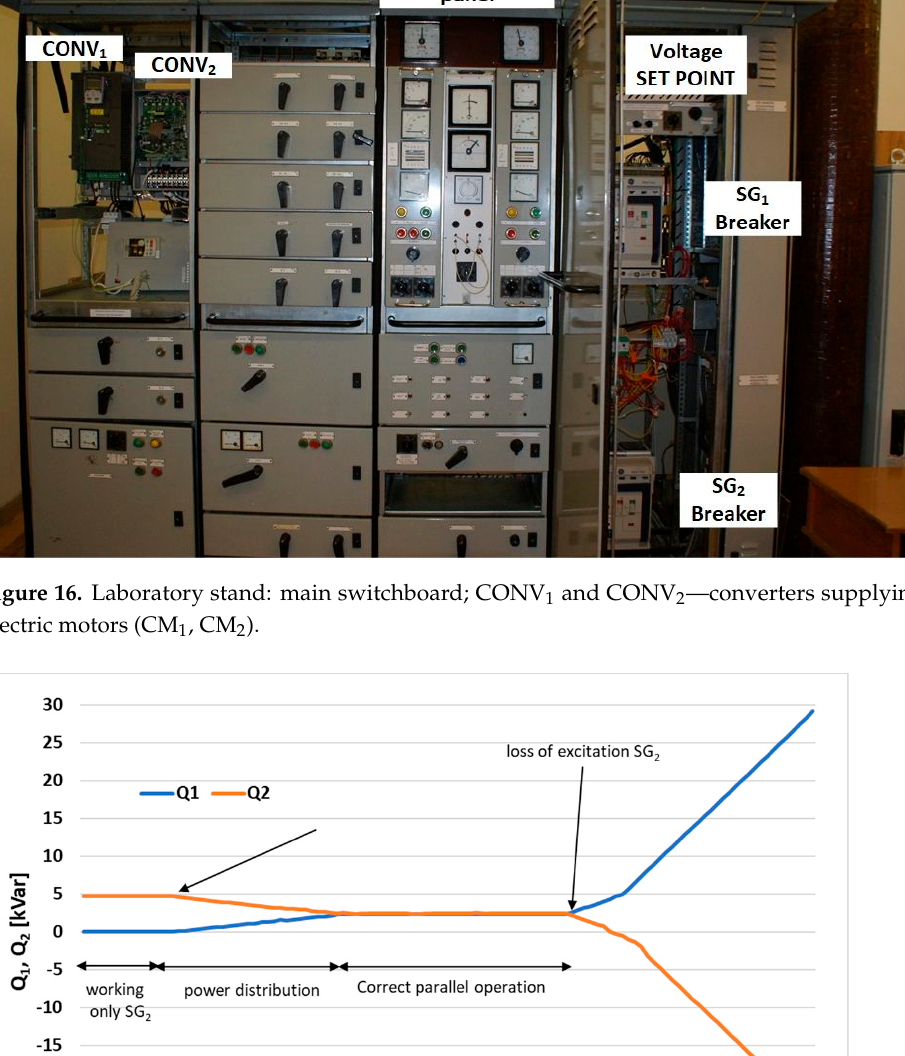
Figure 18. Waveforms of the active power (P 1 and P 2 ) obtained during the laboratory tests. Figure 19 presents the effective values of the apparent currents for both generators. At the moment of partial loss of excitation for SG 2 , the current I 2 began to temporarily decrease (until the value of the reactive current component was zero), and then in- creased—it significantly exceeded the nominal current I N . At the same time, the current I 1 start to increase (faster), exceeding the I N value. Figure 19. Time waveforms of currents I 1 and I 2 obtained during the laboratory tests.